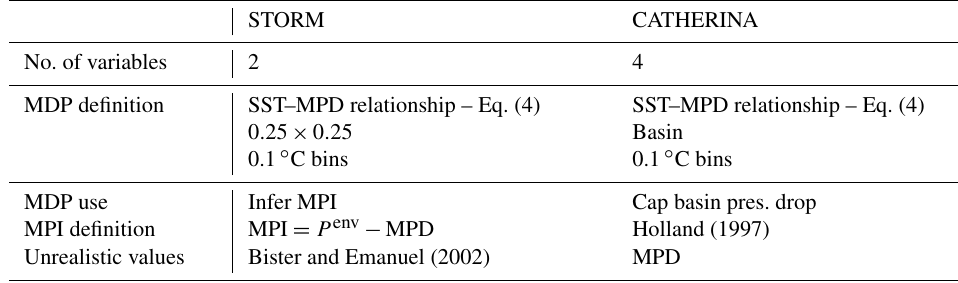
Table A3. Comparison STORM–CATHERINA cyclone intensification module.